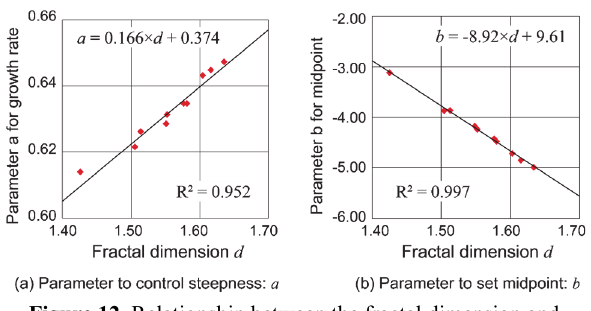
Figure 12 . Relationship between the fractal dimension and parameters.